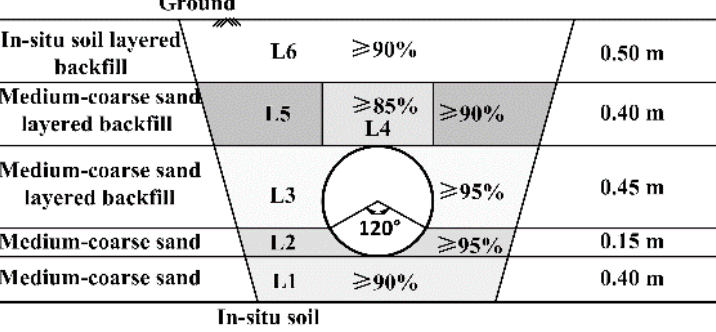
Figure 4. The thickness and material of the backfill in numerical analysis.